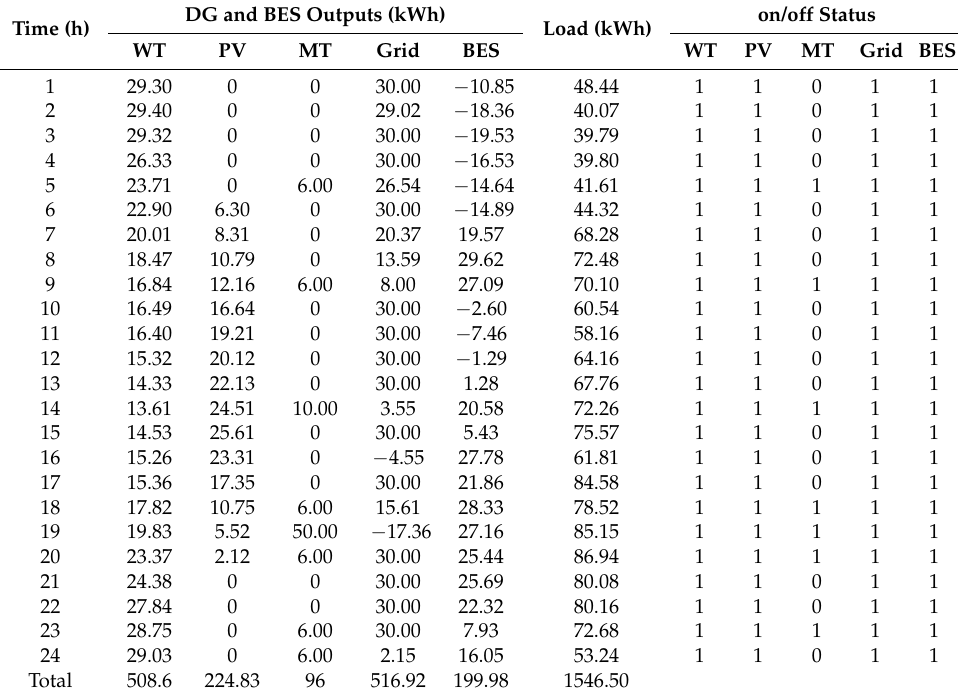
Table 5. Results of Scenario 3 (total cost = 382.60